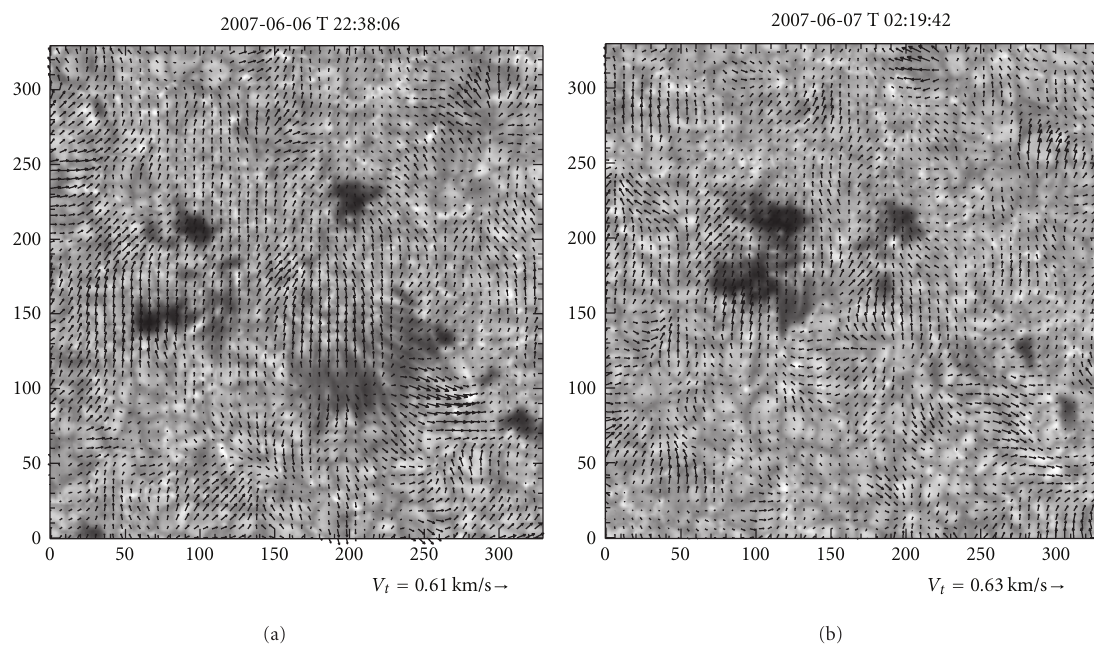
Figure 5: The horizontal velocity vectors overlaid upon G-band image showing the PLFs. (a) Image acquired before the C1.7 class flare. (b) Image acquired after the PLFs decay.